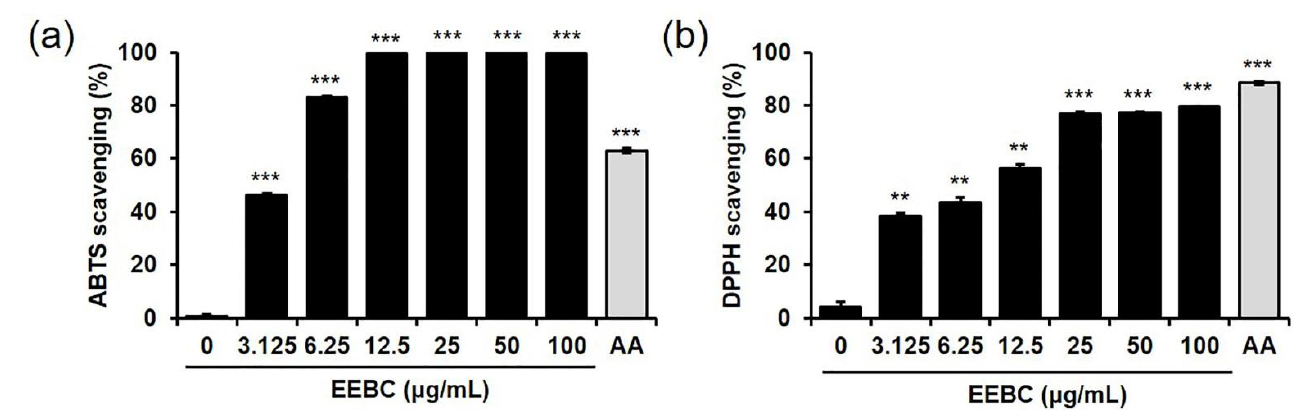
Figure 3. Free radical scavenging activity of EEBC. ( a ) Various concentrations of EEBC (0, 3.125, 6.25, 12.5, 25, 50, or 100 μg/mL) were reacted with equal volumes of ABTS solution for 5 min in the dark at room temperature. Absorbance of the reactants was read at 734 nm using a spectrophotometer; ( b ) Various concentrations of EEBC (0, 3.125, 6.25, 12.5, 25, 50, or 100 μg/mL) were reacted with equal volumes of DPPH solution for 30 min in the dark at room temperature. Absorbance of the reactants was read at 517 nm using a spectrophotometer. Ascorbic acid (AA, 5 μg/mL) was used as a positive control. Each value is presented as the mean ± SEM. ** p < 0.01 and *** p < 0.001 vs. control. EEBC: ethanol extract of Bauhinia coccinea branches . ABTS: 2,2′-azino-bis(3-ethylbenzothiazoline-6-sulfonic acid). DPPH: 2,2-diphenyl-1-picrylhydrazyl.